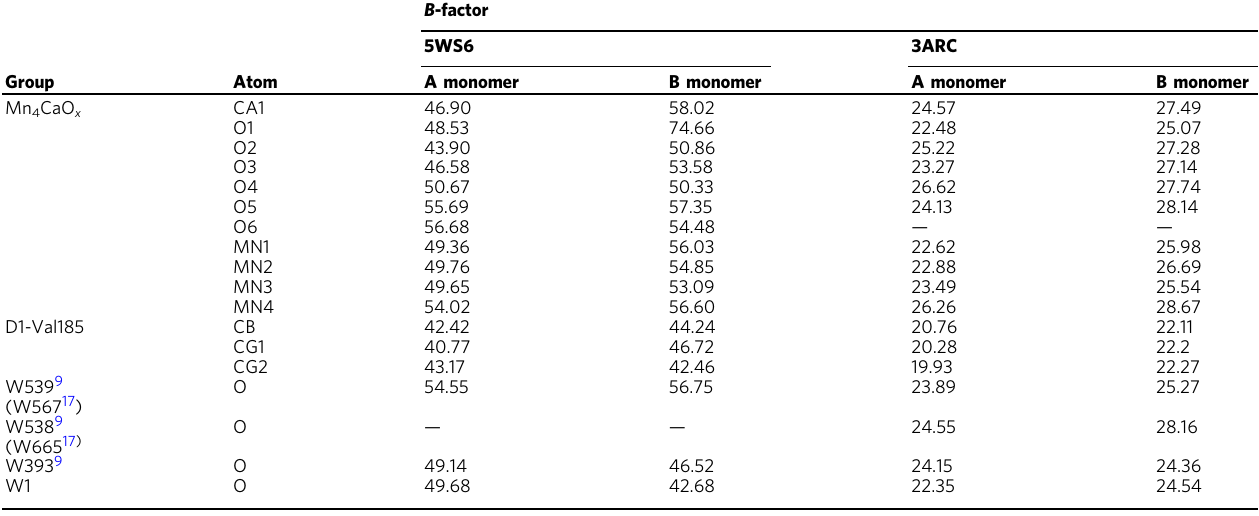
Table 2 B -factor values in the two- fl ash illuminated PSII structure (5WS6) and the 1.9-Å PSII structure (3ARC) (in Å 2 ) B